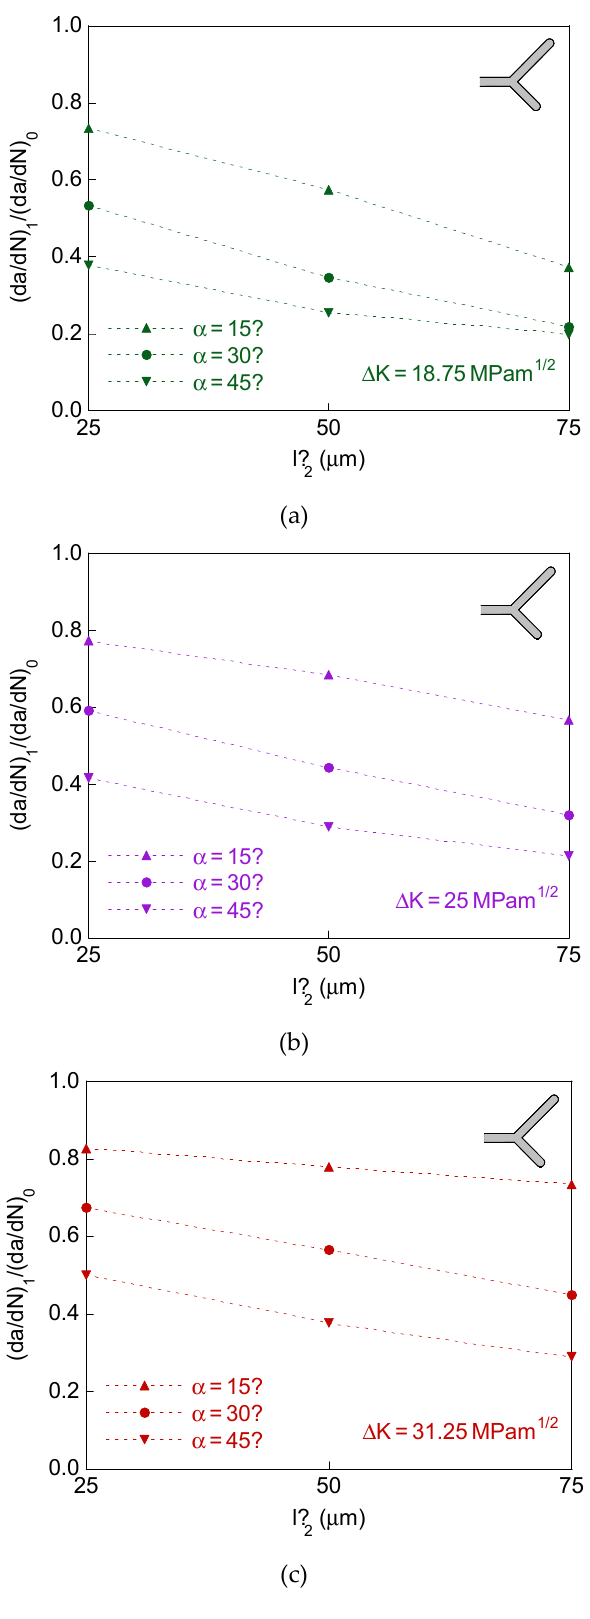
Figure 4. Retardation factor for bifurcated crack tip with different initial projected length and equal initial angle in the two branches: ( a ) Δ K = 18.75 MPam 1/2 ; ( b ) Δ K = 25 MPam 1/2 ; ( c ) Δ K = 31.25 MPam 1/2 .